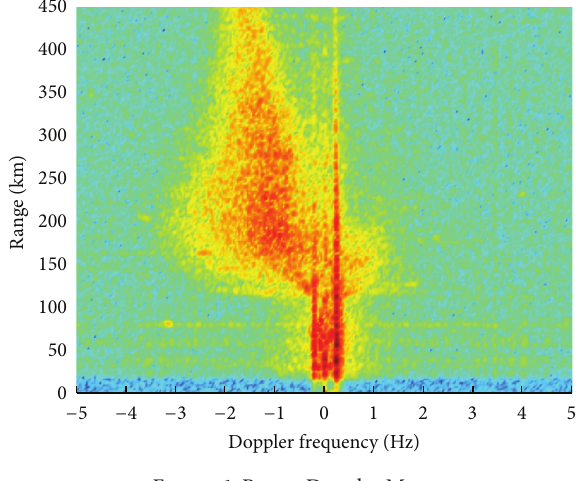
Figure 1: Range-Doppler